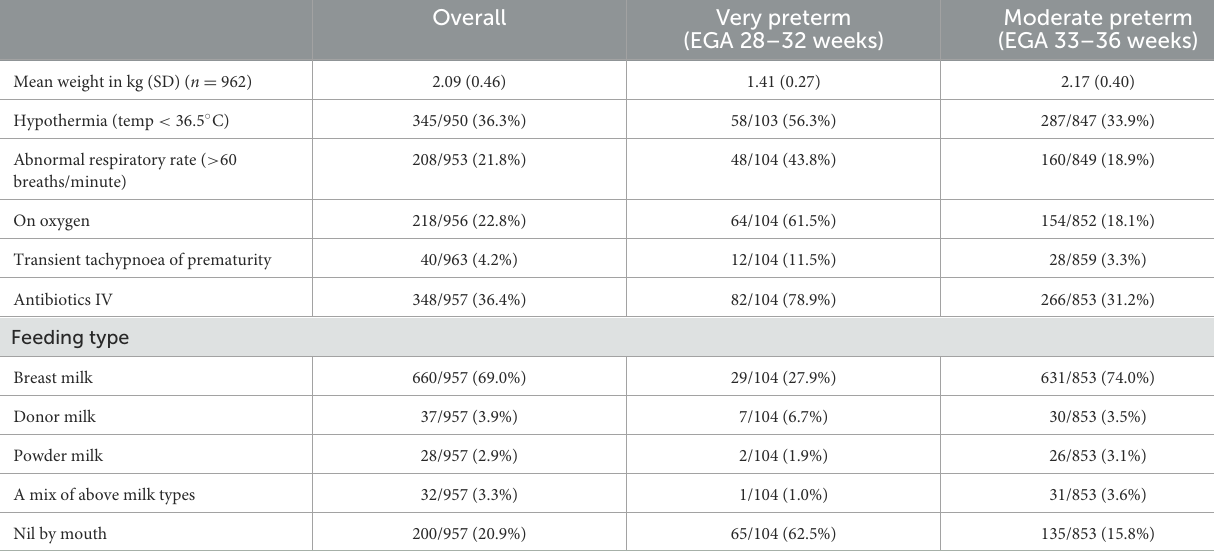
TABLE 3 Characteristics of 963 preterm neonates upon admission to the SMRU SCBU (EGA: estimated gestational age).